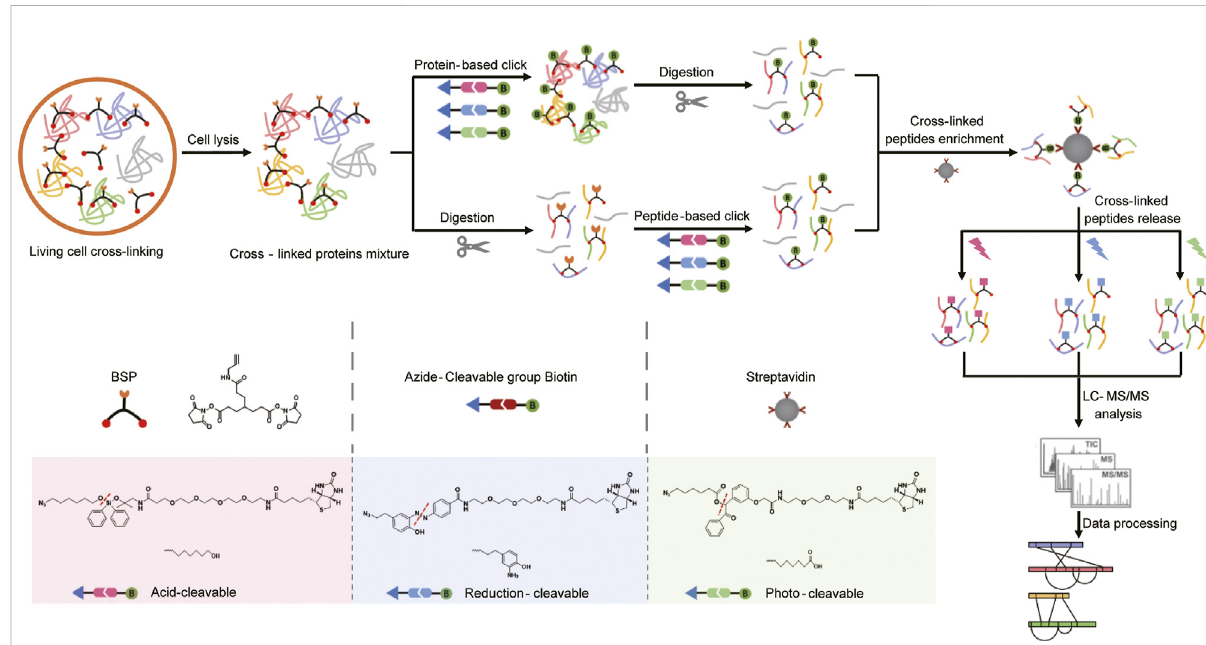
FIGURE 1 Flow diagrams of both protein-based and peptide-based click-chemistry reactions for in vivo cross-link analysis. Bottom left: chemical structures of the cross-linker BSP, three cleavable azide – biotin reagents, and the tags modi fi ed to the cross-linker after cleavage are, respectively, illustrated, in which red dashed lines represent the cleavable